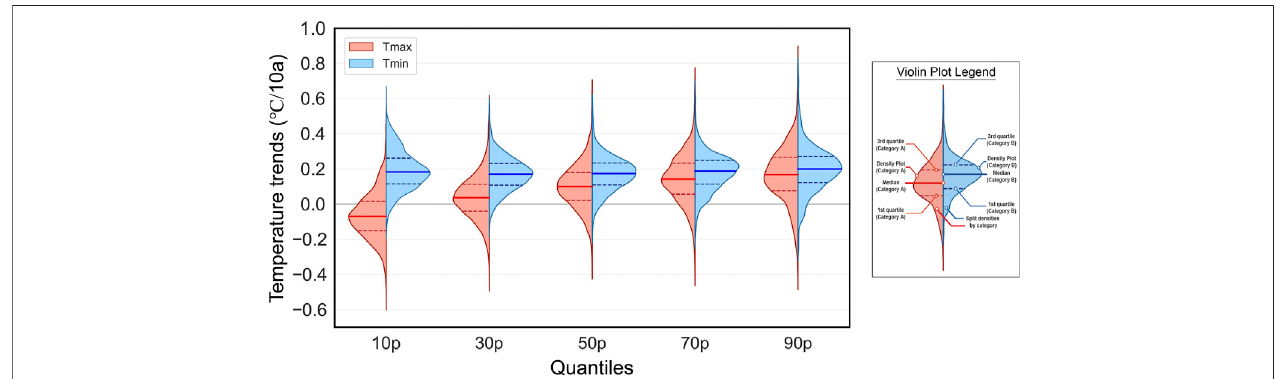
FIGURE 3 | Violin plot (showing kernel density estimate of distribution) of running window quantile trends at 10th, 30th, 50th, 70th, and 90th percentiles for all the grid points at the YRB region, with the differences between Tmax (red) and Tmin (blue). Note that the quantile trend analysis for each point is exactly the same as Figure2 .Thenumberofdataineachviolinis:45differentrunningwindowtrends × 318(265)gridpointsofTmax(Tmin)intheYRBregion.Themeaningsofeachelement within the violin plot can be found in the attached legend box.